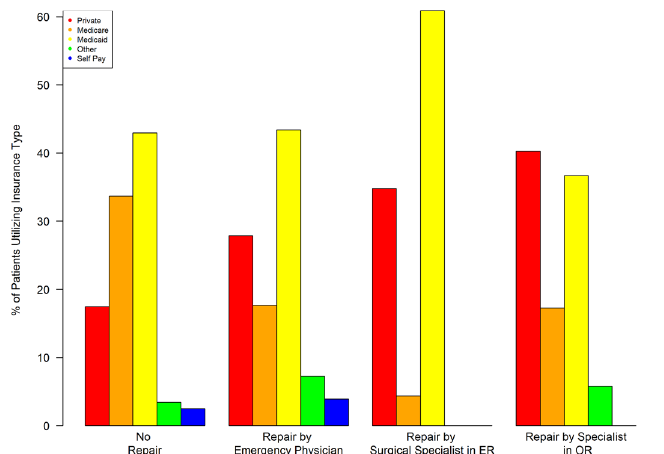
Figure 5. Level of intervention by insurance payer